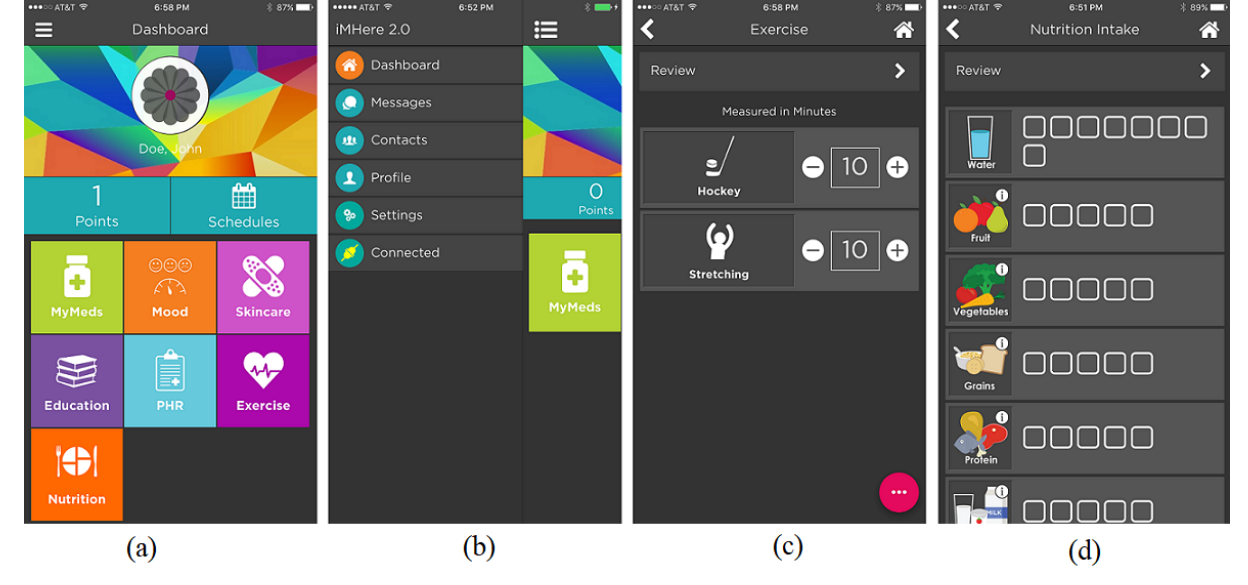
Figure 1. Screenshots of the iMHere 2.0 (a) dashboard, (b) menu buttons, (c) exercise module, and (d) nutrition